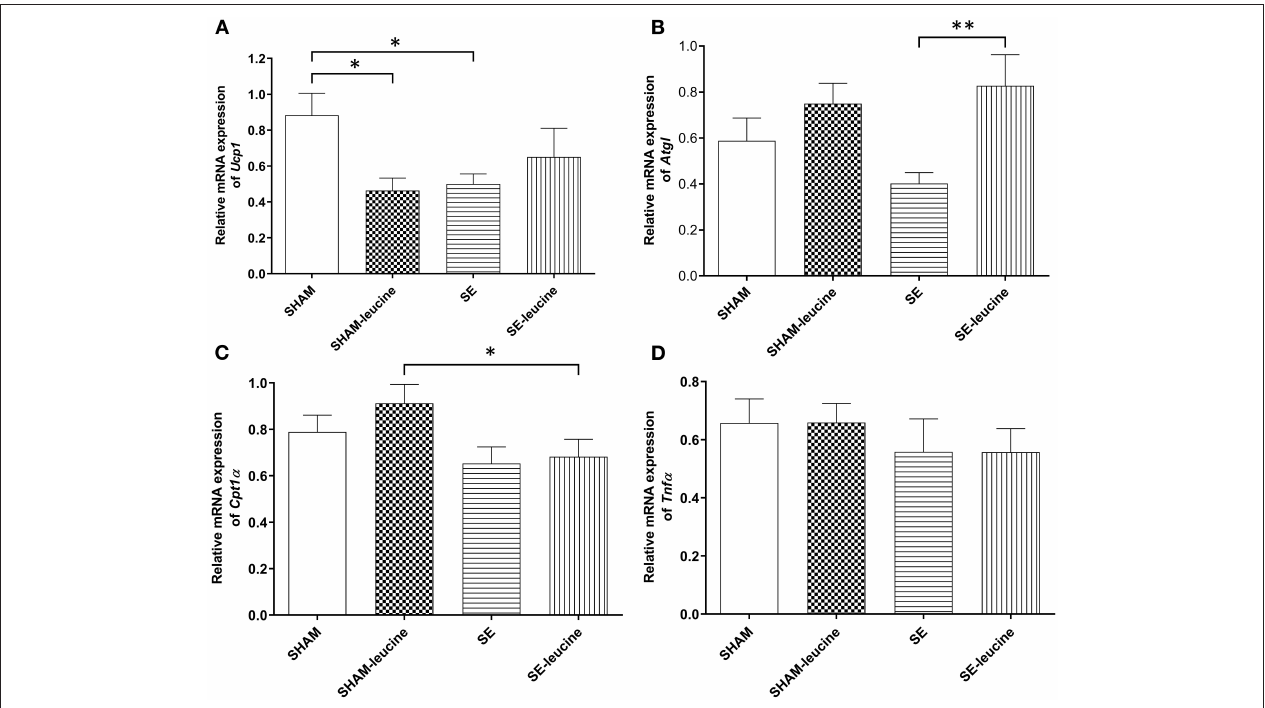
FIGURE 3 | Expression of lipid metabolic markers in the retroperitoneal white fat tissue. mRNA expression of uncoupling protein (Ucp)1 in the brown fat (A) , Atgl (B) , Cpt1 α (C) , and Tnf α (D) in the retroperitoneal fat, in female offspring at 13 weeks ( n = 8). Results are expressed as mean ± SEM. Data were analyzed by two-way ANOVA, followed by post-hoc LSD tests. * P < 0.05, ** P <